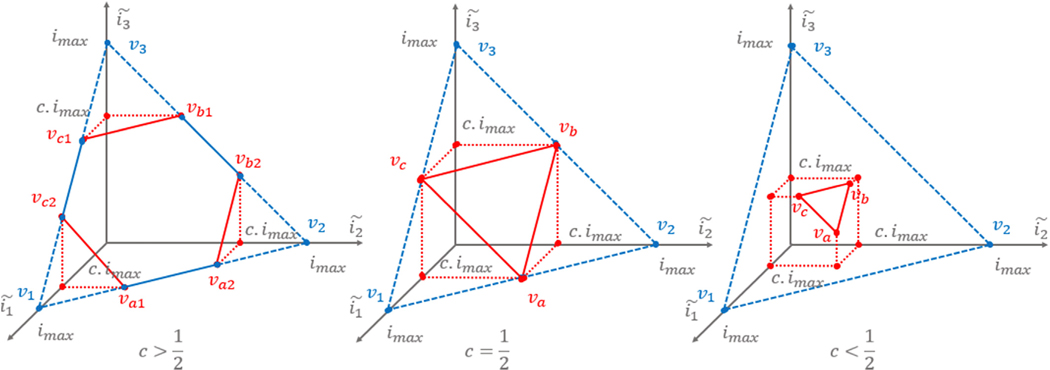
Example of how the standard simplexes in Eq (B.3) are altered with a current limit per electrode lower in absolute value than imax. In this example we set c>12(left),c=12(center),c<12(right). Corners v1; v2; v3 do not longer belong to the truncated simplex, and points va; vb; vc are new corners and thus, possible solutions.3